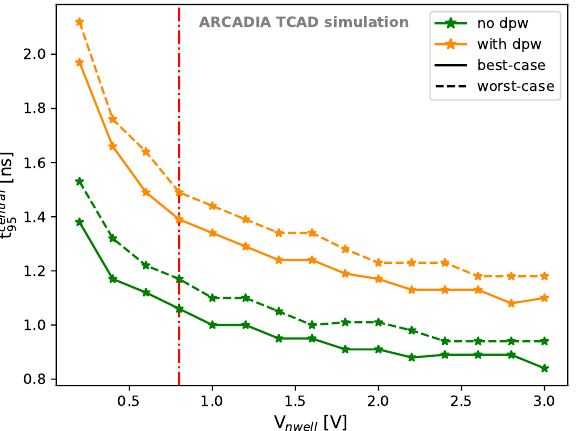
Figure 23. t central as a function of the voltage V nwell applied to the sensing node for best-case and 95 worst-case scenarios. The vertical red line indicates the default value of V nwell = 0.8V. A way to further reduce the collection time is to explore thinner sensors. Figure 24 demonstrates that the charge collection time t central is proportional to the sensor thickness. 95 does not exceed 6 ns. In the best-case